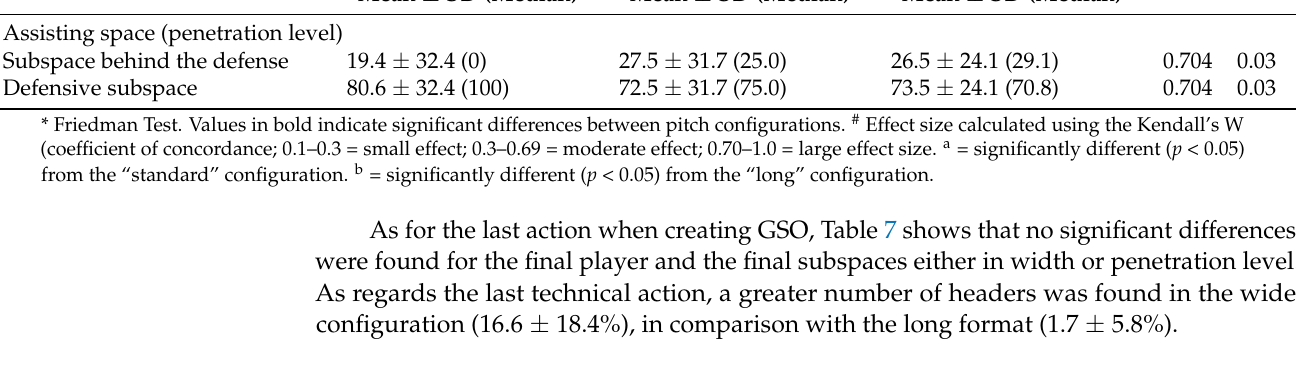
Table 7. Comparison of the final action between the three different pitch configurations in the team possessions that led to